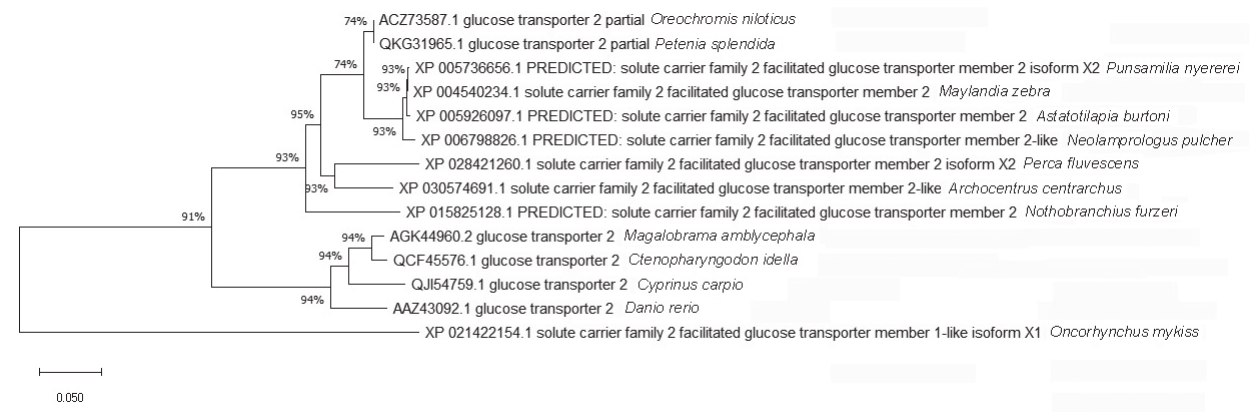
FIGURE 3 | Phylogenetic tree based on the sequence of glut2 (glucose transporter 2) from Petenia splendida and other teleosts using the neighbor-joining (NJ) method. Values at branch points represent percentage frequencies for tree topology after 1,000 interations.